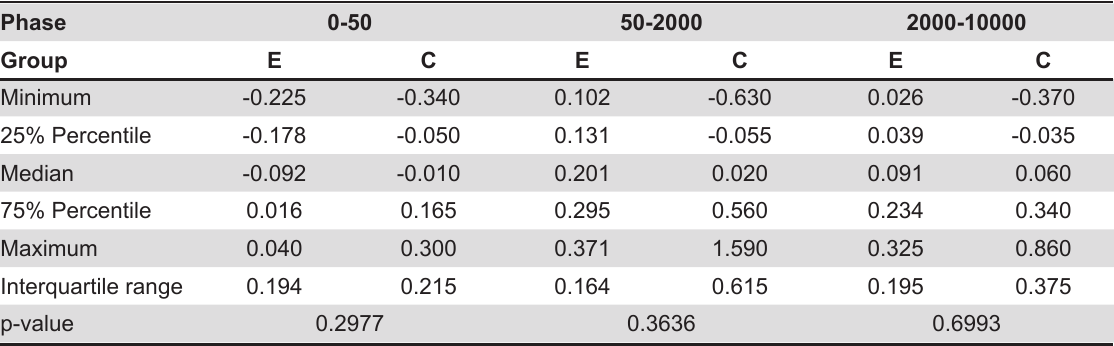
E=electroplated female part, C=cast female part